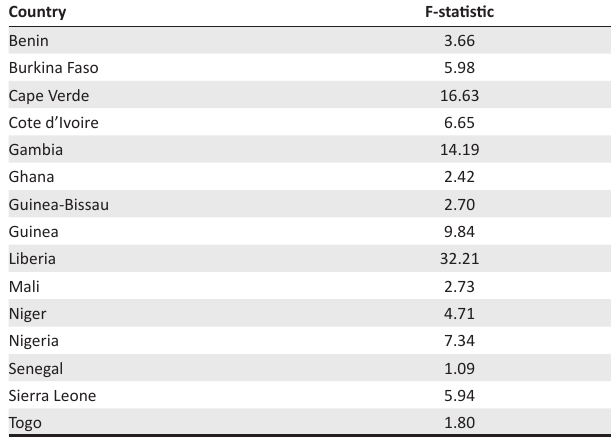
TABLE 2: Unit root tests. TABLE 3: Bounds tests.